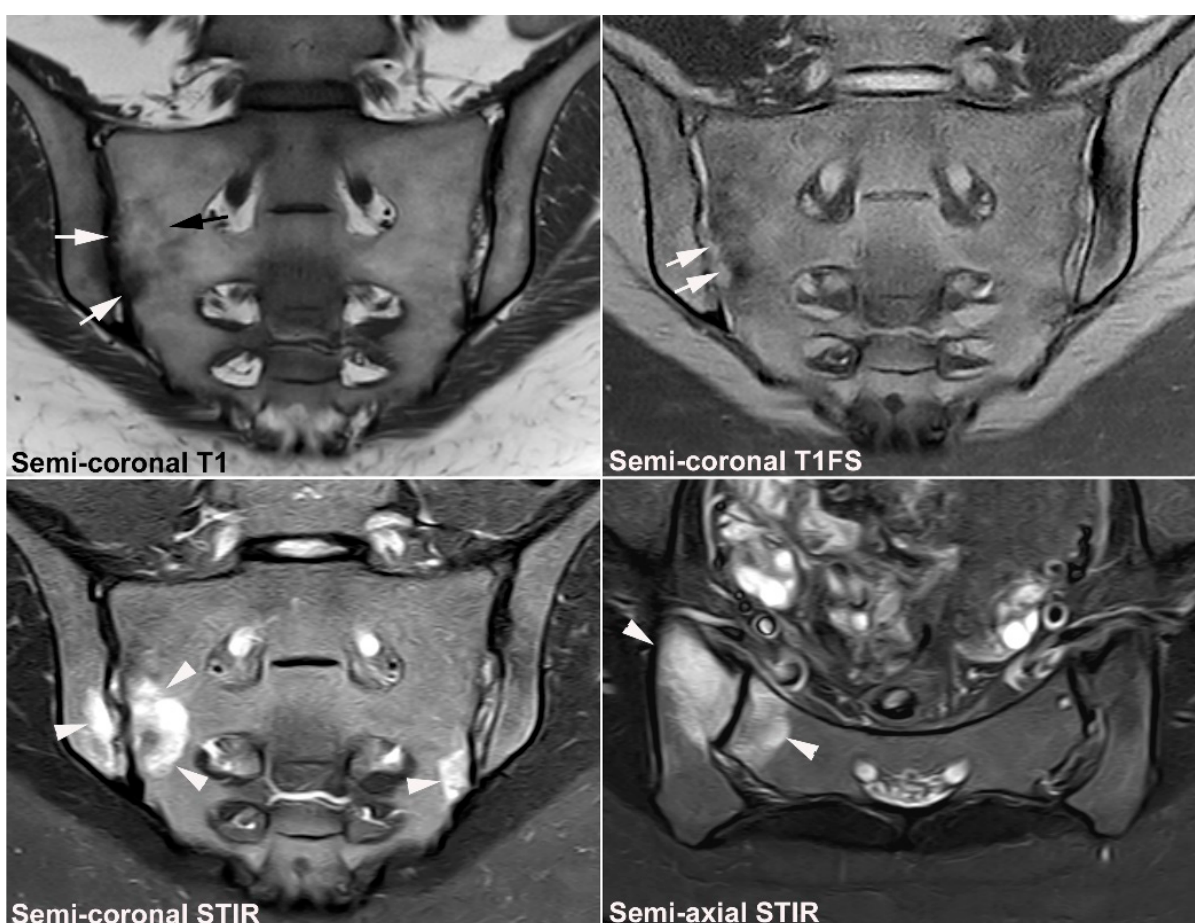
Figure 1. Predominant active sacroiliitis changes in a 31-year-old woman with inflammatory low back pain for 8 months, normal radiographic findings, CRP 22 mg/L (normal < 8 mg/L) and HLA B27 negative. Upper row of images: semi-coronal T1 and T1FS; lower row: semi-coronal STIR and semi-axial STIR images. There is manifest subchondral BME at the inferior part of the joints, especially on the right side (arrowheads), in addition to right-sided sacral erosions (white arrows) with an adjacent area of faint subchondral fat deposition (black arrow).